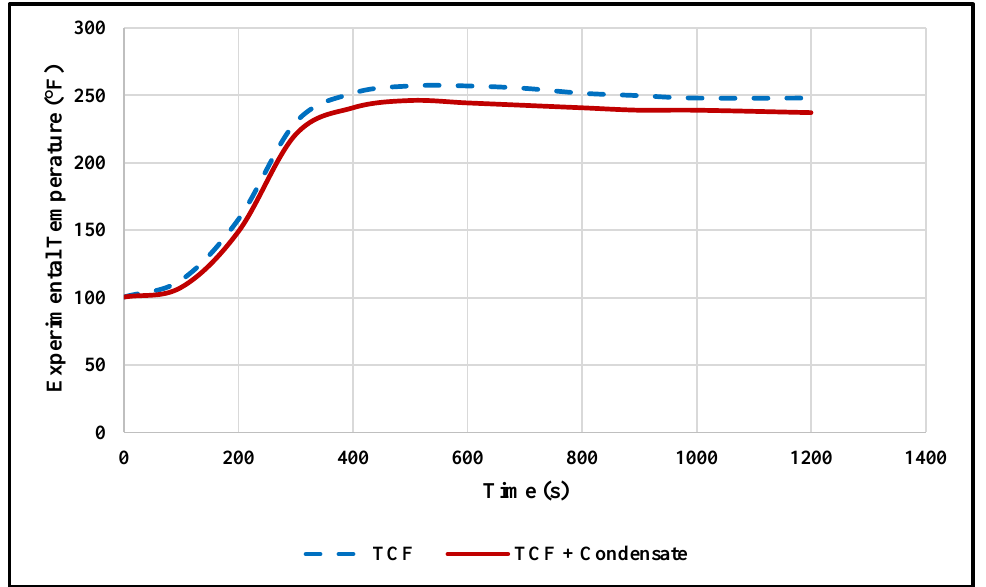
Figure 5. Temperature profiles for pure thermochemical-fluid (TCF) and TCF-condensate system.